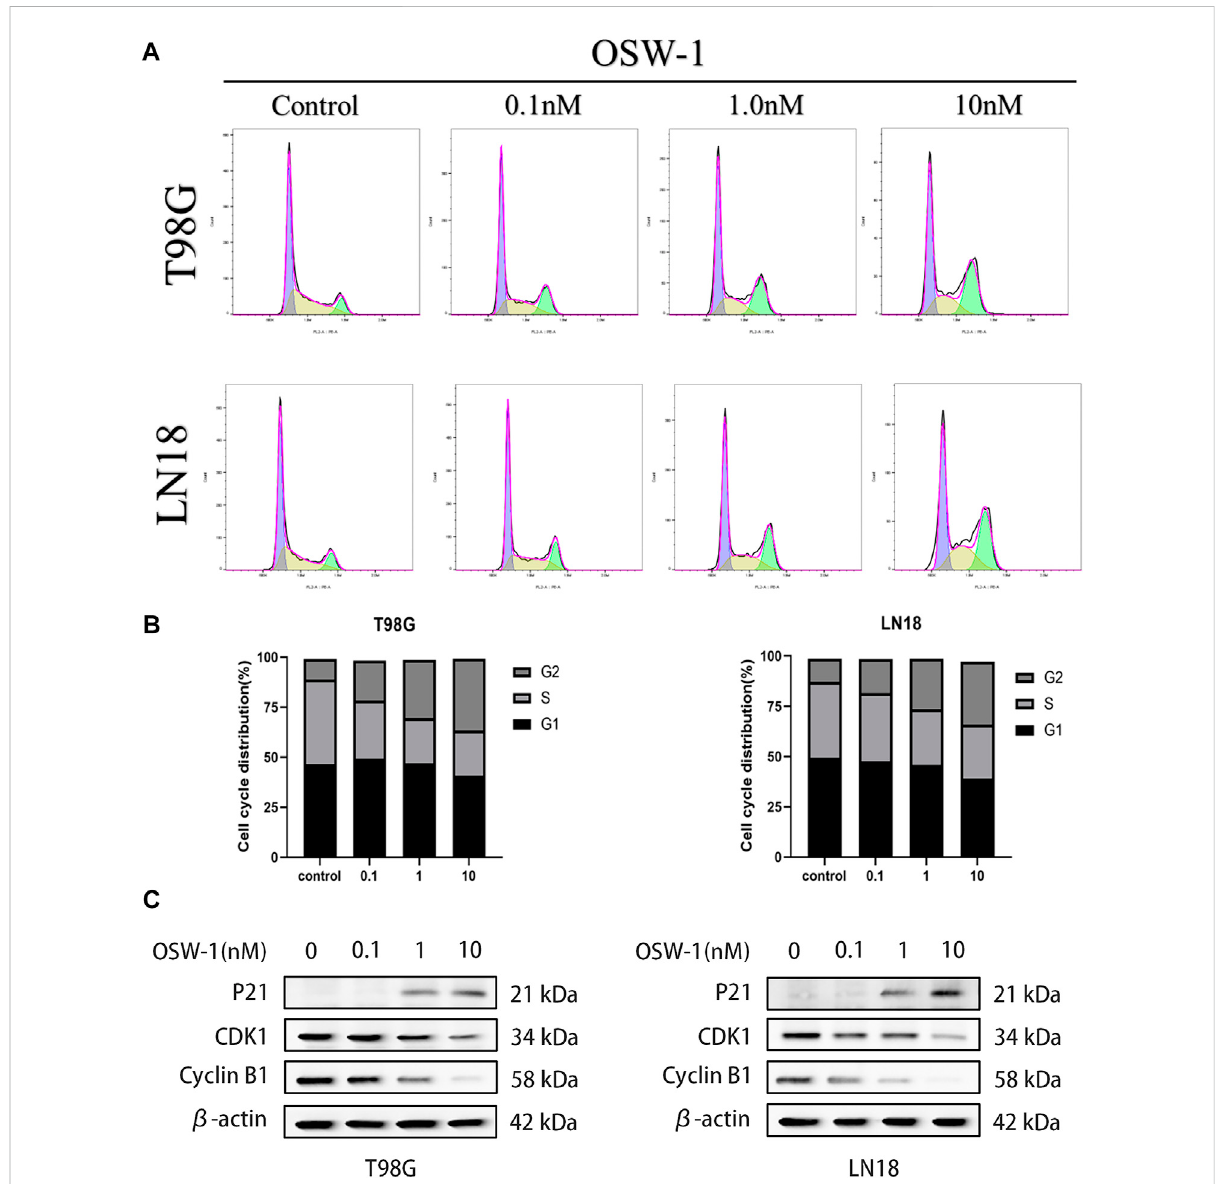
FIGURE 5 OSW-1arrestedcellcycleattheG2/Mphaseingliomacells (A) CellcyclechangesofgliomacellstreatedwithdifferentconcentrationsofOSW- 1 for 24 h were detected and analyzed using fl ow cytometry and the FlowJo software (B) Percentages of glioma cells in the G2/M phase were signi fi cantly increased in a dose-dependent manner (C) Western blot shows the changes of cell cycle-related proteins after OSW-1 treatment for 24